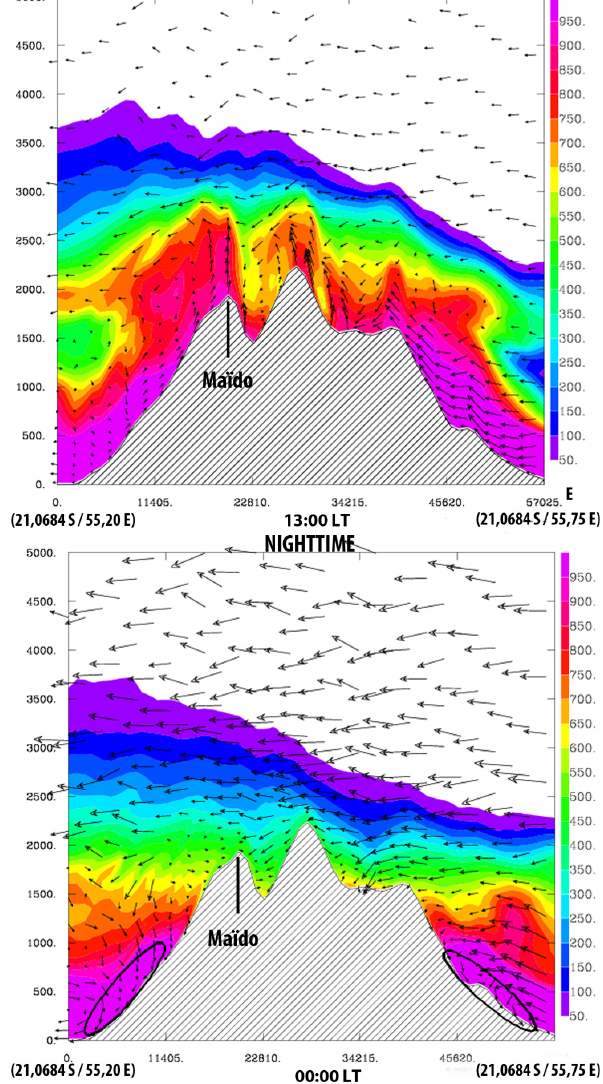
Fig. 10. Simulation ALIZ5 – vertical cross section (W-E, indicated on Fig. 9, top) of the ABL tracer concentration (colorscale in per mil of the concentration in the ABL) at 13:00LT (top) and 00:00LT (bottom).